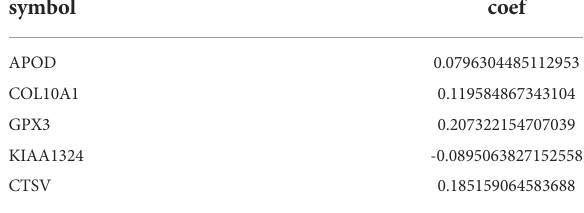
TABLE 1 The fi ve risk genes and their coef fi cients involved in the construction of the model. symbol